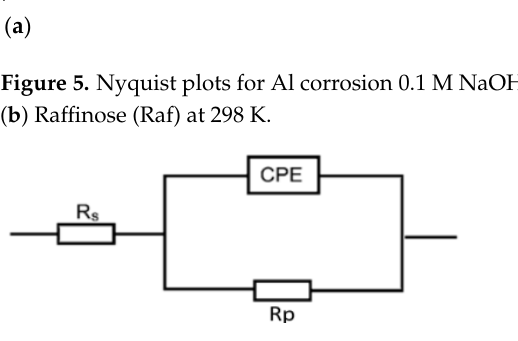
Figure 6. Equivalent circuit employed to suit the obtained EIS spectra in Al corrosion in 0.1 M NaOH medium and with amygdalin and raffinose.